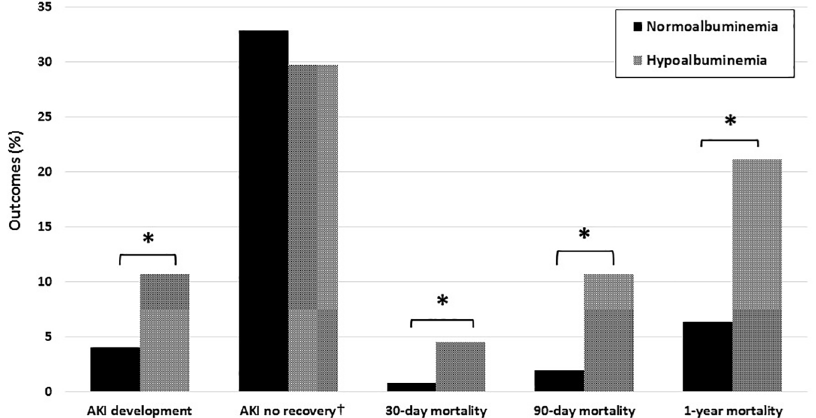
Fig 2. Clinical outcomes according to the serum albumin groups. * P < 0.001. † The statistical analysis was performed in only 1,002 patients with AKI. AKI, acute kidney injury.